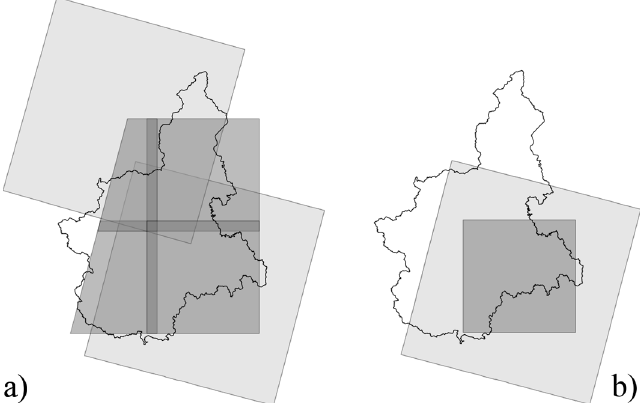
Figure 1. Test areas used for geometrical ( a ) and spectral ( b ) validation. Footprint of S2 and L8 data are shown, respectively, in dark and light grey.